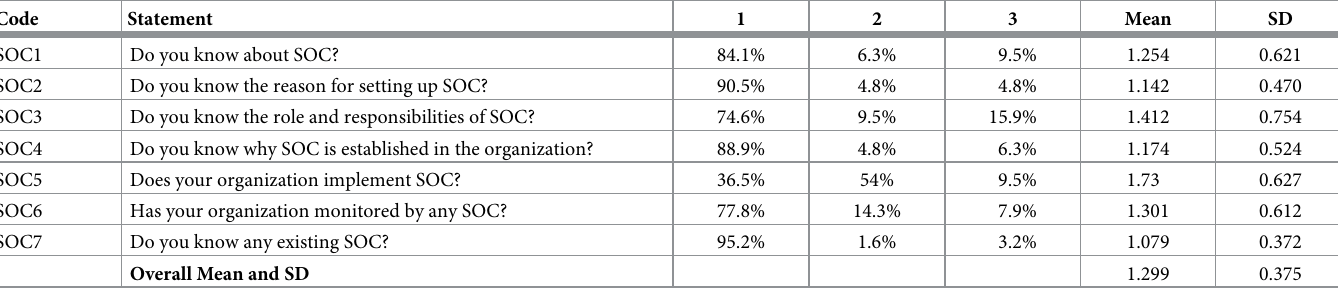
Table 7. Questionnaire on general information about